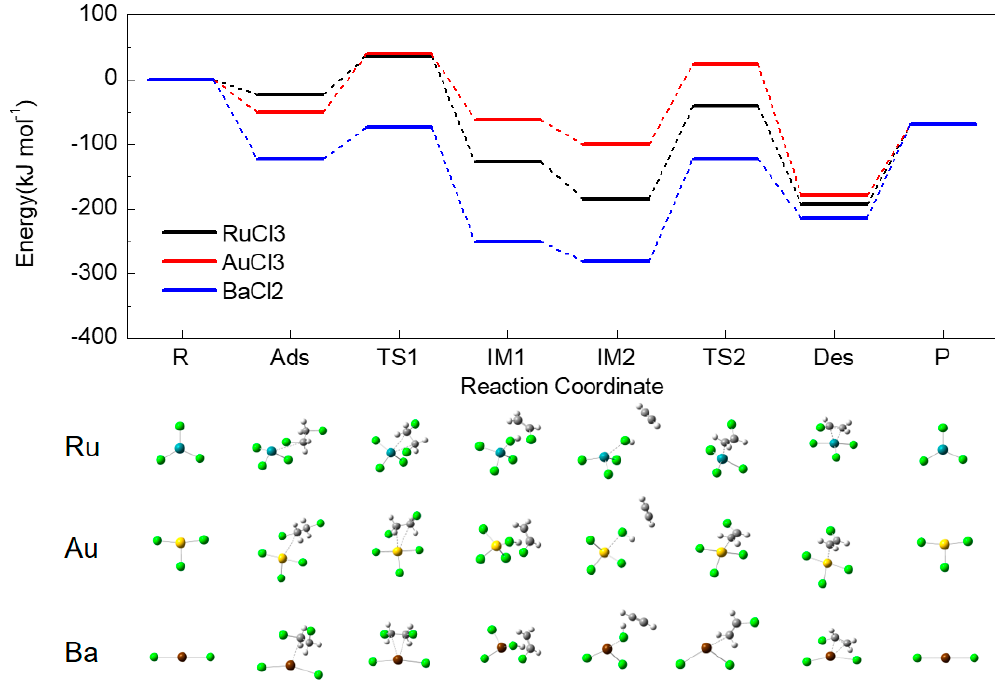
Figure 2. Energy profiles and corresponding structures of species for DCE-exchange reaction: DCE decomposition pathway. Free molecules of DCE, C 2 H 2 , HCl, and VCM are omitted for clarity.